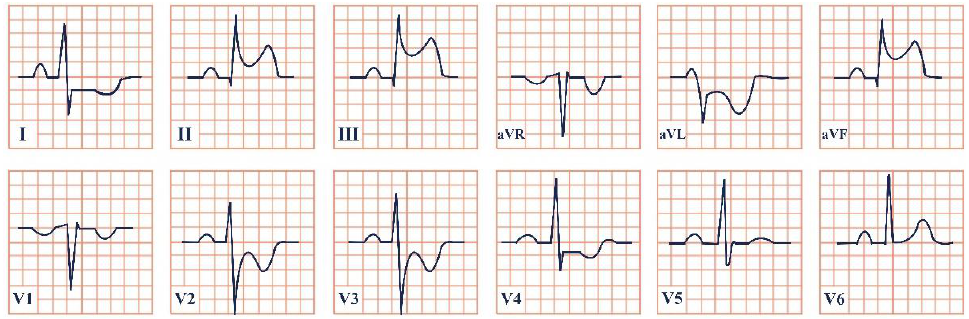
Figure 3. Electrocardiogram aspect in Kounis syndrome.